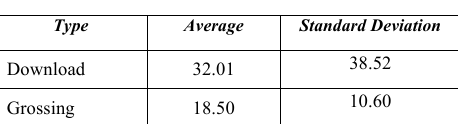
Fig. 3. Histogram of top grossing games after be normilized and